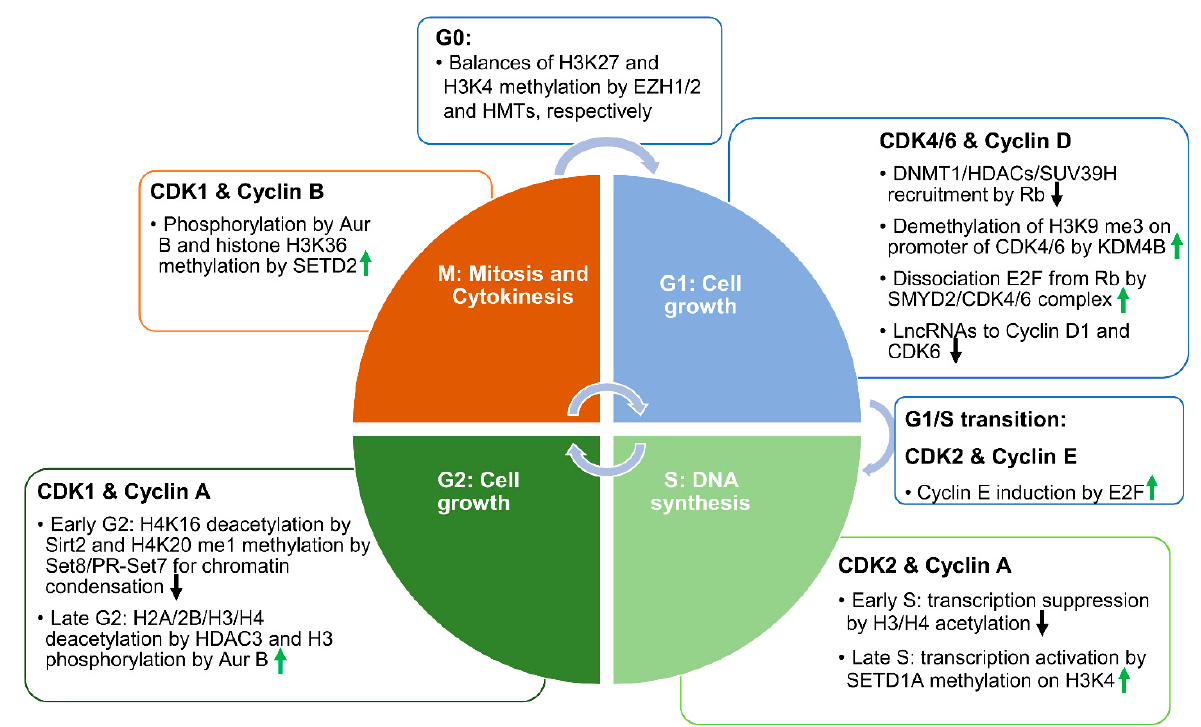
Figure 1. The associations between CDKs, cyclins, and the epigenetic mechanisms in each phase of the cell cycle. Schematic diagram showing the functions of different CDK–cyclin pairs in each phase of the cell cycle. In the G 1 phase, CDK4 or CDK6 coupled with cyclin D phosphorylates and removes Rb from the Rb–E2F complex to facilitate E2F-mediated transcription of cell cycle effectors. CDK4 and CDK6 interact with a histone methyltransferase—SMYD2—to regulate its activity. SMYD2 methylation of Rb may facilitate the phosphorylation of Rb by CDK4/6. In addition, SMYD2 directly regulates the transcription of CDK4 and CDK6. In the S phase, CDK2 coupled with cyclin A or E reinforces the phosphorylation of Rb to promote DNA synthesis. In the early S phase, the acetylation of histones suppresses transcription, while later in the S phase, SETD1A-mediated histone methylation reactivates transcription, and promotes the transition from the S phase to the G 2 phase. In the G 2 phase, CDK1 coupled with cyclin A or B phosphorylates histone tails at different sites to promote mitotic entry. HDAC3-mediated histone deacetylation is involved in this process. In the meantime, SIRT2-mediated deacetylation of histone H4K16 and SET8/PR-SET7-mediated methylation of H4K20 synergistically regulate cell cycle progression. Eventually, when histone H3Ser10 is globally phosphorylated, cells enter the mitosis phase. In the M phase, SETD2-mediated tubulin and histone methylation promotes cytokinesis and the separation of cells into two daughter cells. In the G 0 phase, histone methyltransferase (HMT)-mediated H3K4 trimethylation and EZH1/2 -mediated H3K27 trimethylation dynamically control the chromatin status. Upward ‐ pointing green arrows represent the propelling effects on the cell cycle. Downward ‐ pointing black arrows represent the inhibiting effects on the cell cycle.